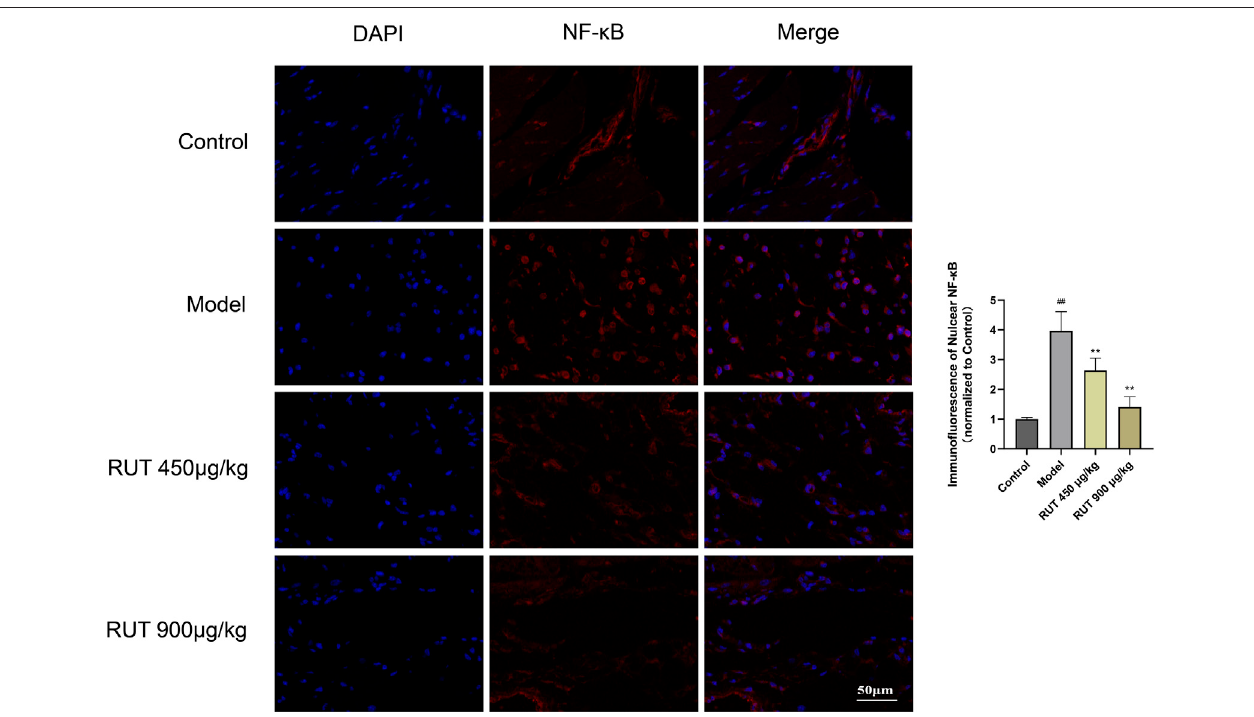
FIGURE 4 | Immuno fl uorescence analysis for the effect of RUT on NF- κ B nuclear translocation (IF × 400 magni fi cation; Scare bar: 50 μ m; n (cid:1) 3).